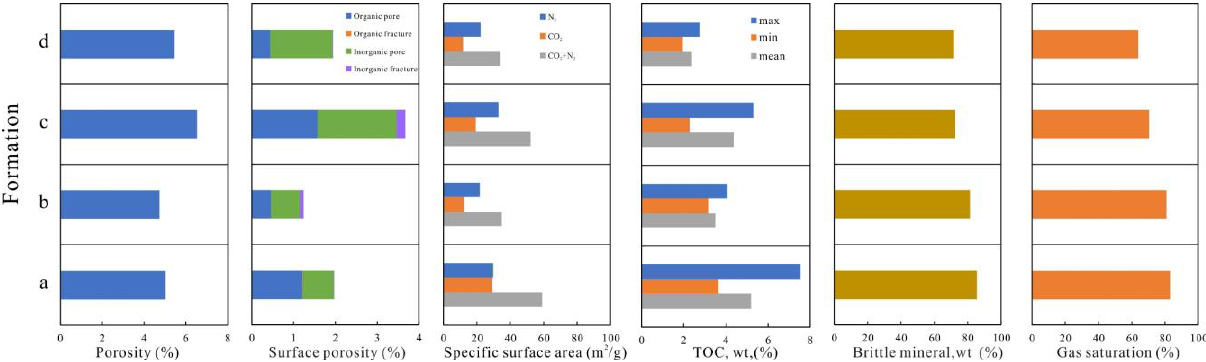
Figure 8. Pore structure, mineral composition and gas bearing characteristics of S 1 1 1 −1